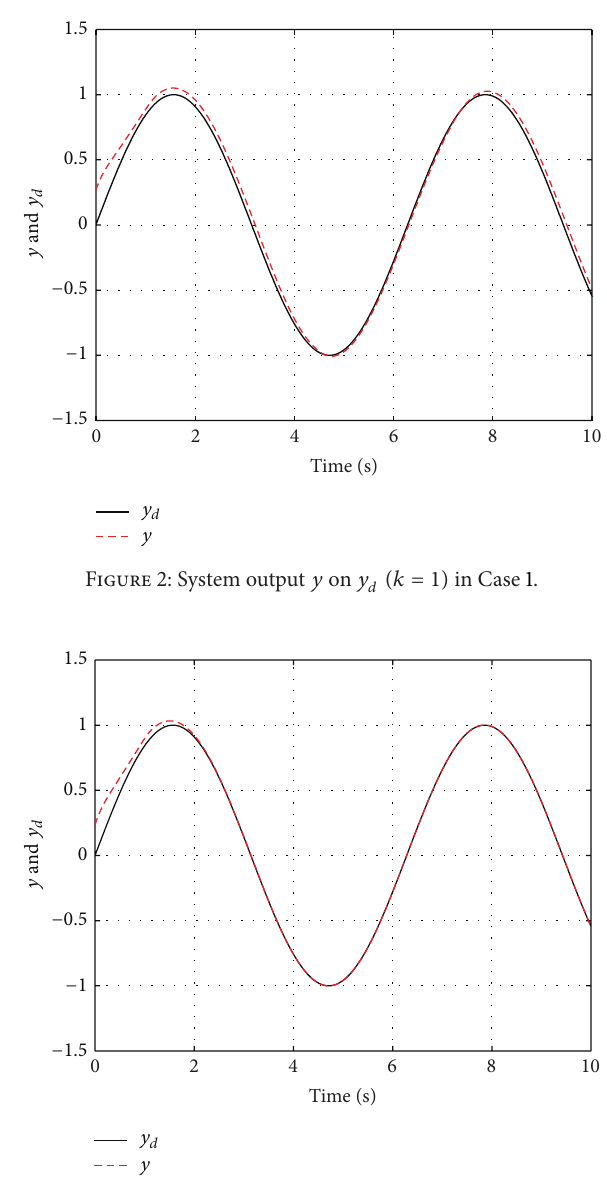
Figure 3: System output 𝑦 on 𝑦 𝑑 (𝑘 = 10) in Case